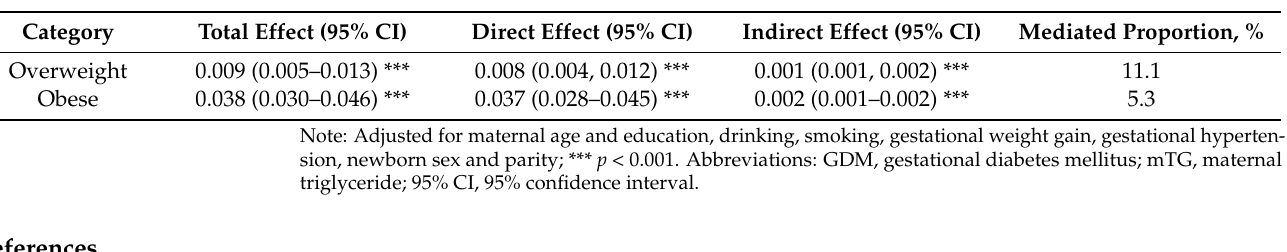
Table A1. The total effect, direct effect, and indirect effect on the relationship of maternal over- weight/obesity and the risk of fetal macrosomia mediated by both GDM and high mTG levels when the 85th percentile was considered as the cut-off value for high mTG